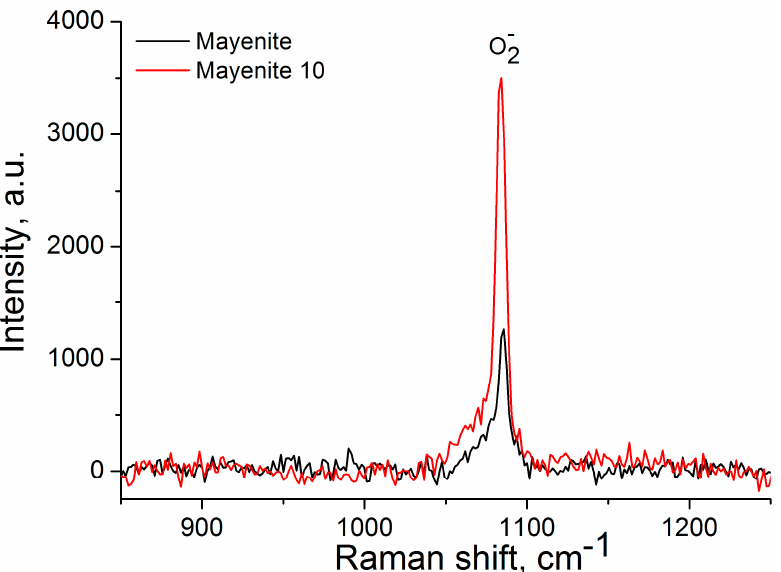
Figure 2. Raman spectra of mayenite (black) and mayenite 10 (red) catalysts.